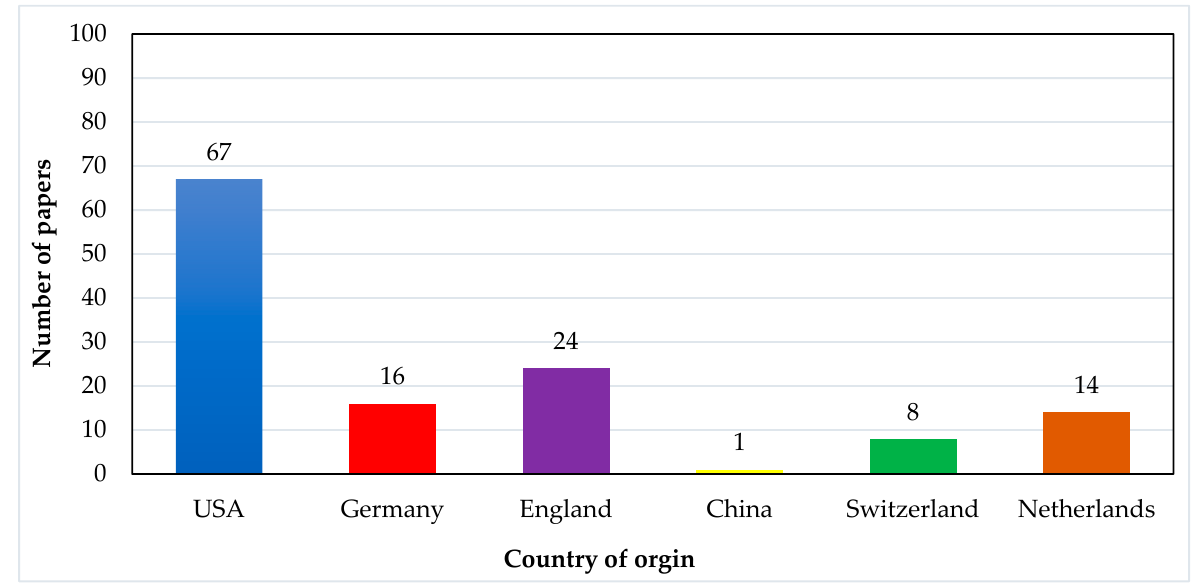
Figure 8. Graphical presentation of the number of papers vs. country of origin. Table 7. Top 10 authors with 2 or more published